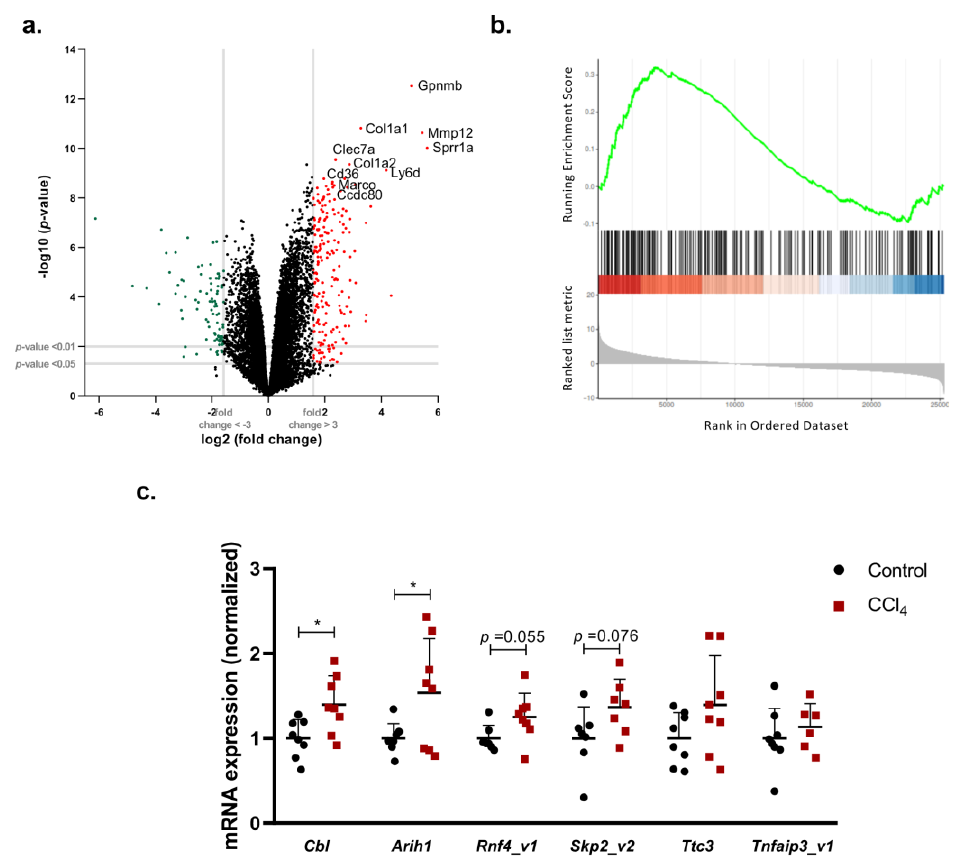
Figure 3. Genes related to ubiquitination are significantly dysregulated at the transcriptional level in carbon tetrachloride (CCl 4 )-induced liver fibrosis. ( a ) Volcano scatterplots showing statistical significance ( p value) versus magnitude of change (fold change) and ( b ) polyubiqutination pathway enrichment analysis plots from a gene set enrichment analysis (GSEA) of female mice treated with CCl 4 for 8 weeks (0.2 mL / kg / day, 3 times a week) vs. untreated mice (GSE141821). Red and green scattered points represent the most significant (* p < 0.01) upregulated and downregulated genes, respectively, that have a fold change higher than 3. ( c ) mRNA hepatic levels quantified by RT-PCR of genes involved in the ubiquitination pathway comparing CCl 4 -induced liver fibrosis and wild-type animals. Abbreviations: Cbl . Casitas B-lineage Lymphoma, Arih1. Ariadne RBR E3 ubiquitin protein ligase 1, Rnf4. Ring finger protein 4, Skp2. S-phase kinase-associated protein 2, Ttc3. Tetratricopeptide repeat domain 3, Tnfaip3. tumor necrosis factor alpha-induced protein